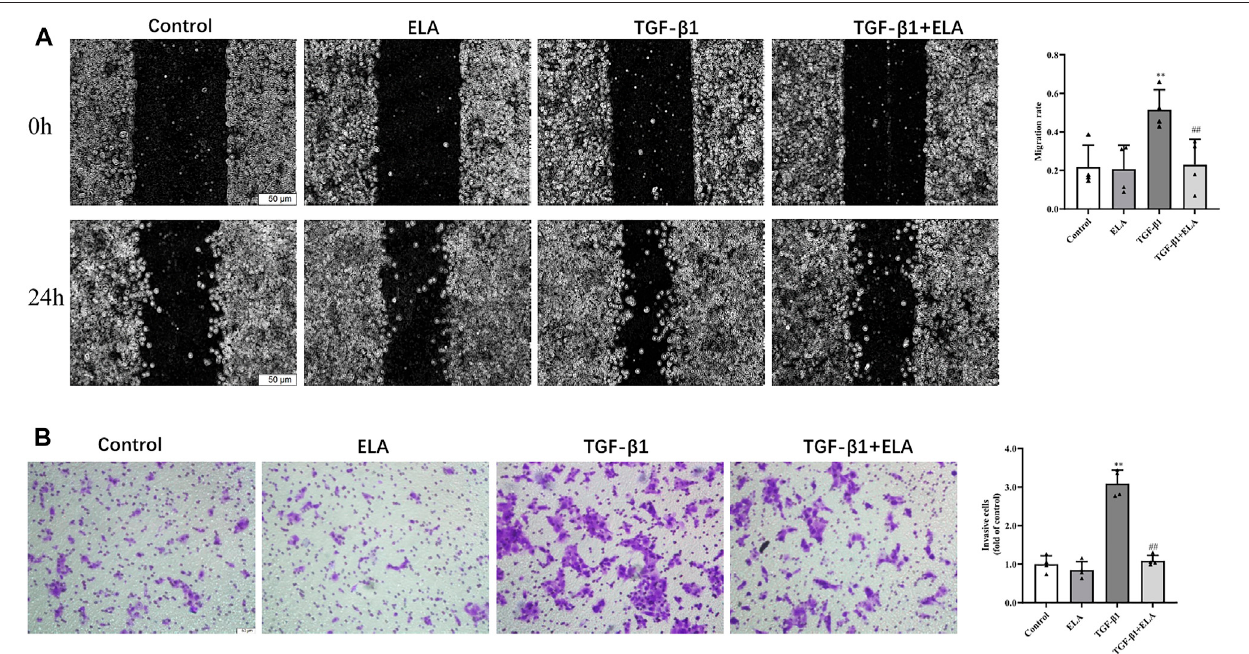
FIGURE 3 | Effects of ELA-32 on TGF- β 1-induced migration of HMrSv5. HMrSv5 was divided into four groups according to different treatments: 1) Control group wherecellswereculturedwithDMEMmediumcontaining10%FBSafter24 hofsynchronization;2)ELAgroupwherecellsweretreatedwithELA-32(10 μ M)for24 h;3) TGF- β 1 group where cells were treated with TGF- β 1 (10 ng/ml) for 24 h; and TGF- β 1+ELA group where cells were co-treated with TGF- β 1 (10 ng/ml) and ELA-32 (10 μ M) for 24 h. Wound healing (A) and Transwell (B) was observed under optical microscope (scale bar = 50 μ m). ImageJ software was used for data statistical analysis. The experiments were repeated four times. Data are expressed as mean ± SD, ** p < 0.05 vs. control group; ## p < 0.05 vs. TGF- β 1 group. Abbreviations: ELA, elabela; TGF- β 1, transforming growth factor- β